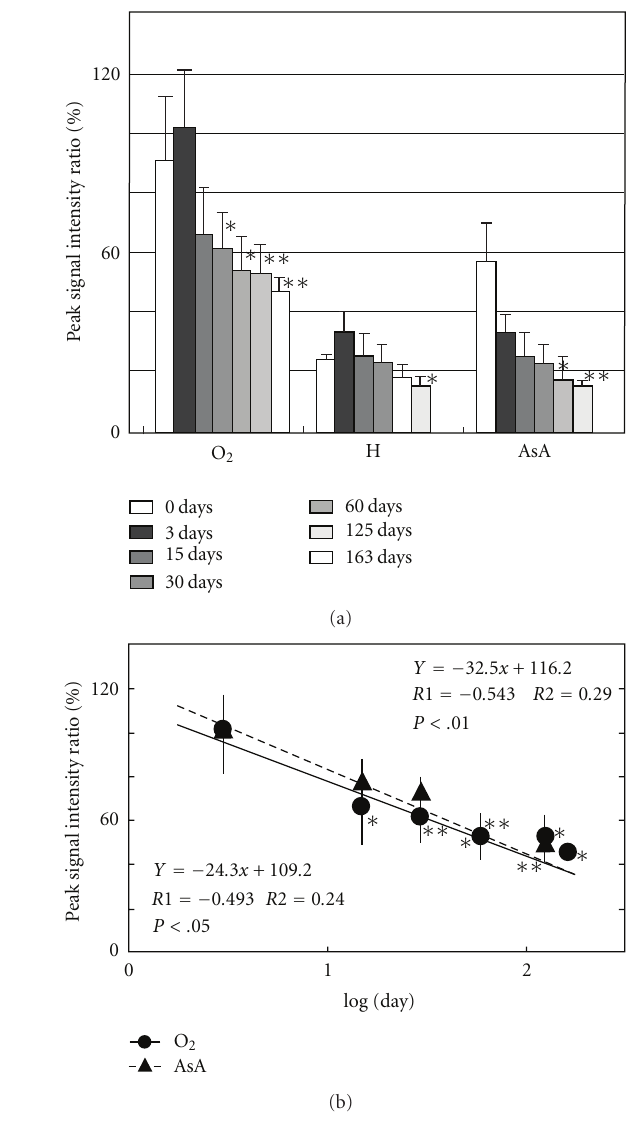
Figure 3: (a) Postmortem DMPO-adduct signal intensity in mouse brain. The columns and the lines show the postmortem signal intensity ratios of brain and S.E.M. of the means ( n = 8). The y - axis shows the percentage of peak signal intensity ratio, which was calculated by assuming that the intensity of MnO (500nmol/L) was 100%. ∗ P < . 05, ∗∗ P < . 01, versus 0 days. (b) Time course of postmortem DMPO-adduct signal intensity ratio in mice brain. The Y -axis shows the percentage of peak signal intensity, which was calculated by assuming that the intensity at 3 day postmortem was 100%. X -axis is expressed in Log(day). ∗ P < . 05, ∗∗ P < . 01, versus 3 days. The regression lines, correlation coe ffi cient ( R1 ), the square of R1 ( R2 ) and the probability of error ( P -value) were calculated.